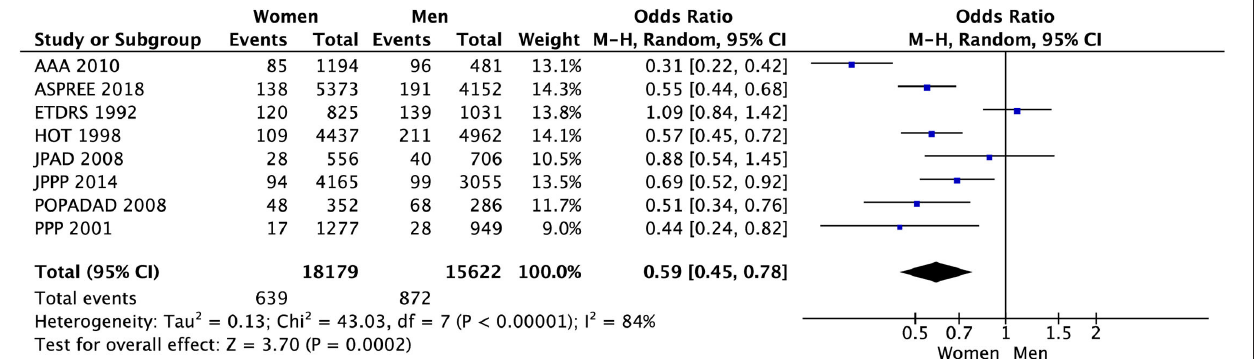
FIGURE 8 | Major cardiovascular events in women and men taking aspirin.